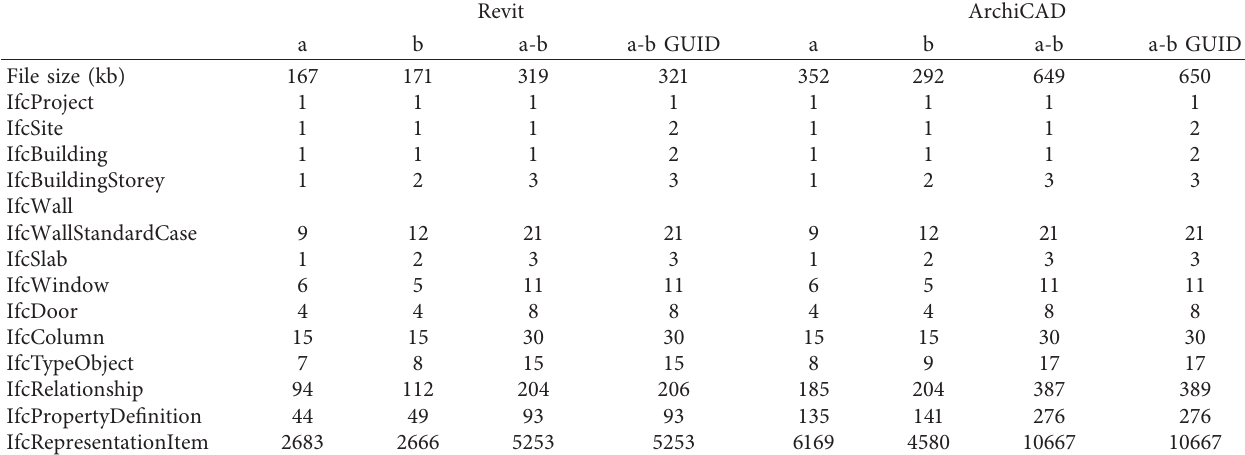
Figure 13: IFC model display of six scenes: (a) the first floor model of a building, (b) the second floor model of a building, (c) the architecture model, (d) the structural column model, (e) one-story structural column and the external wall, and (f) one-story external wall, the interior wall, windows, and doors. Table 1: Entity statistics for scenarios a and b.